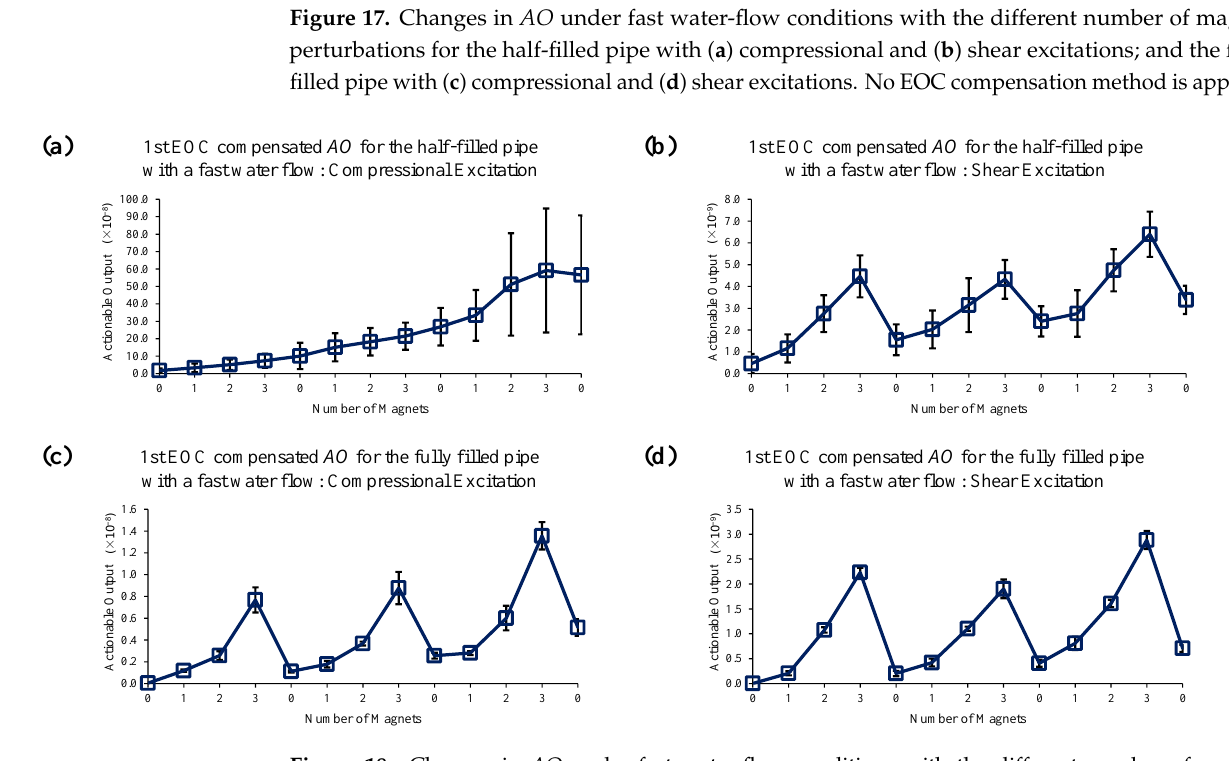
Figure 18. Changes in AO under fast water-flow conditions with the different number of magnet perturbations for the half-filled pipe with ( a ) compressional and ( b ) shear excitations; and the fully filled pipe with ( c ) compressional and ( d ) shear excitations. Only the 1st EOC compensation method is applied.